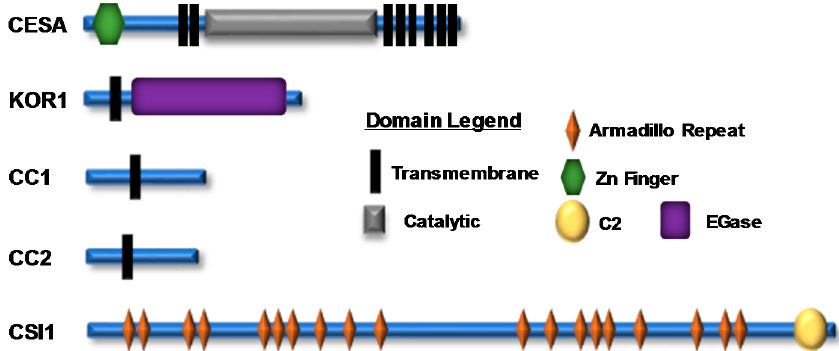
Figure 2. A representation of cellulose synthase A (CESA) and cellulose synthase complex (CSC)-associated proteins; their domain structure and location are shown. There are numerous experimentally identified phosphorylation sites within the N-terminal and catalytic domains of CESA proteins and within various CSC accessory proteins (Supplementary Table S1). The icons corresponding to each domain are shown in the domain legend.